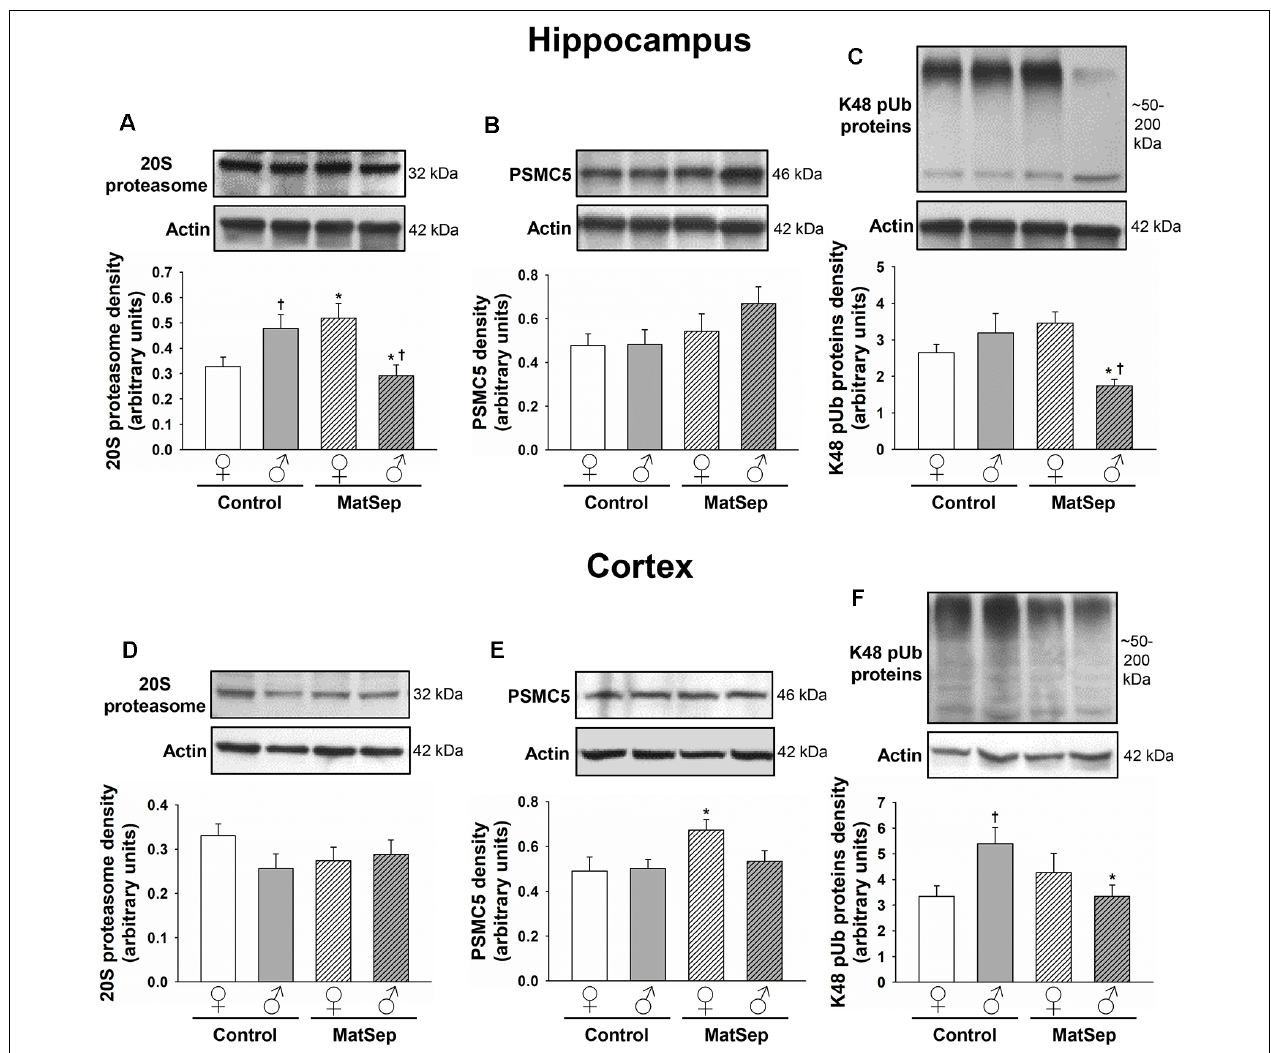
FIGURE 4 | Immunoblot analysis of proteasomal markers from hippocampal and cortical homogenates from adult rats subjected to MatSep. Panels above each graph show representative blots for (A,D) 20S proteasome, (B,E) PSMC5, and (C,F) K48 pUb proteins. Bar graphs represent densitometric analysis of protein expression normalized to actin and averaged over at least three separate blots. * p ≤ 0.05 vs. same-sex Controls; † p ≤ 0.05 when comparing between